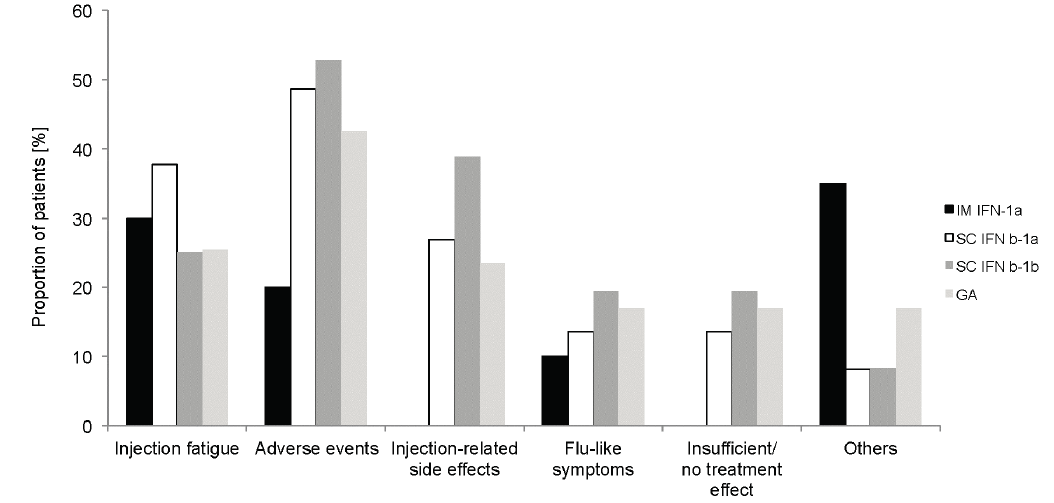
Figure 1. Reasons for stopping previous MS-specific treatment stratified by type of disease-modifying therapy (DMT) (multiple entries permitted). IM IFNb-1a, intramuscular interferon beta-1; SC, subcutaneous; GA, glatiramer acetate.